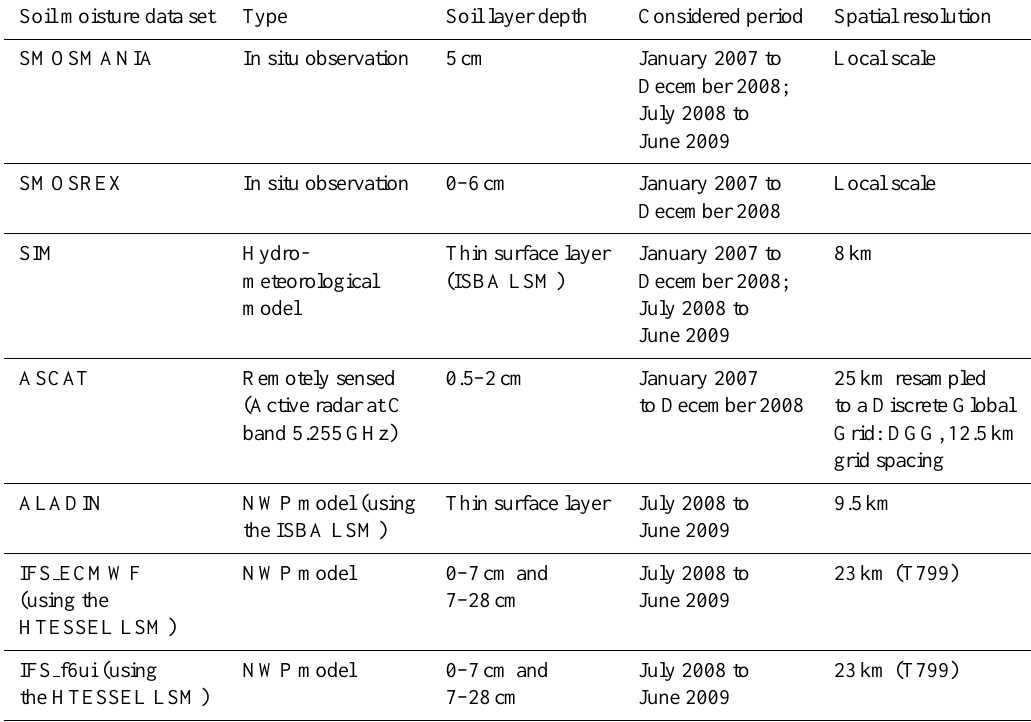
Table 1. Presentation of the different soil moisture products used in this study. NWP and LSM stand for numerical weather prediction, and land surface model, respectively.